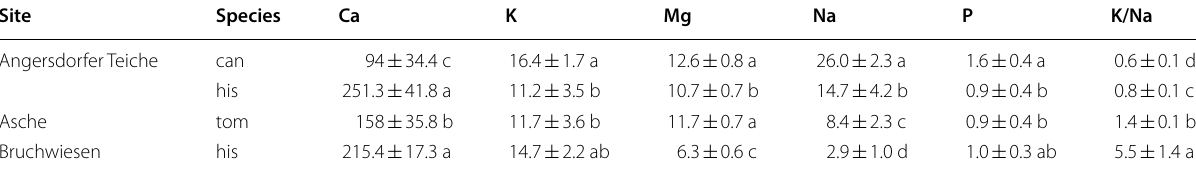
SD) of charophytes from Angersdorfer Teiche, Asche, and Bruchwiesen ±